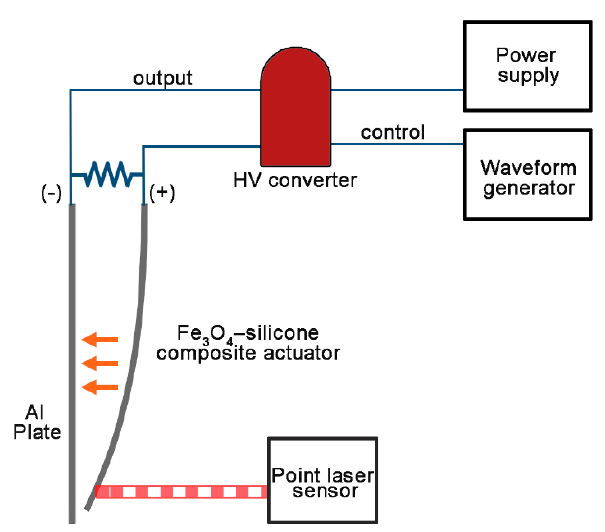
Figure 2. Schematic of the circuit configuration and experimental set up. A high voltage is supplied to Fe 3 O 4 -silicone composite actuators and controlled using a waveform generator. The + and − ports of the high voltage output are connected to the actuator and aluminum plate, respectively. The distances moved by the actuator are measured using a point laser sensor.